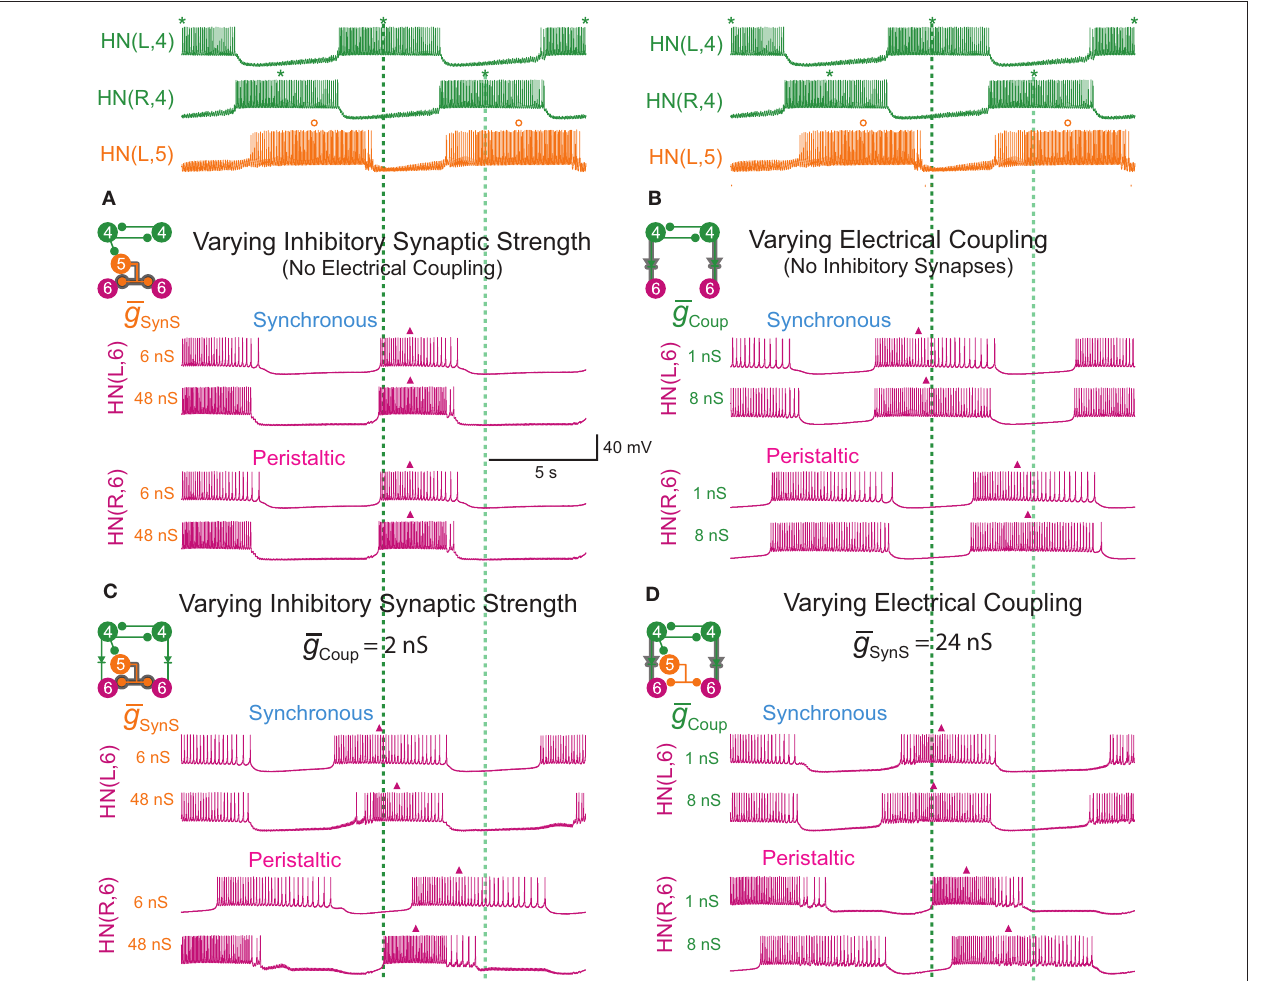
shadowing indicates which inputs were varied. (A,B) In the middle premotor interneurons, neither inhibitory synaptic input ( g SynS ) nor electrical coupling ( g Coup ) acting alone can alter their phasing as g or g is varied. The phase of both the SynS Coup HN(6) bursts do not change appreciably when either g SynS or g Coup alone are